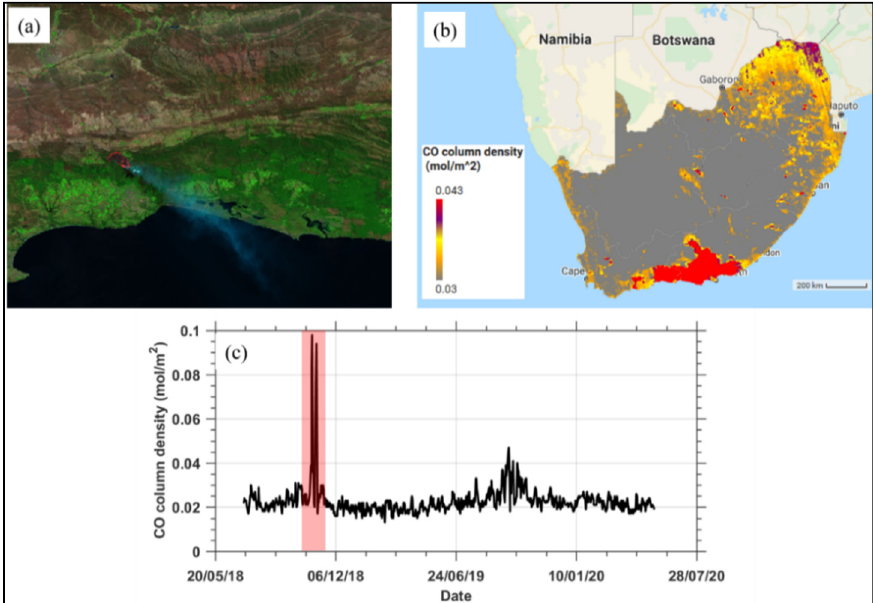
Figure 7. ( a ) The forest fire burning in the Witfontein Plantation during October–November 2018 as recorded by the Sentinel-2 satellite; ( b ) Carbon Monoxide column density as measured by Sentinel-5; ( c ) daily Carbon Monoxide column density over the study area between 5 July 2018 and 20 May